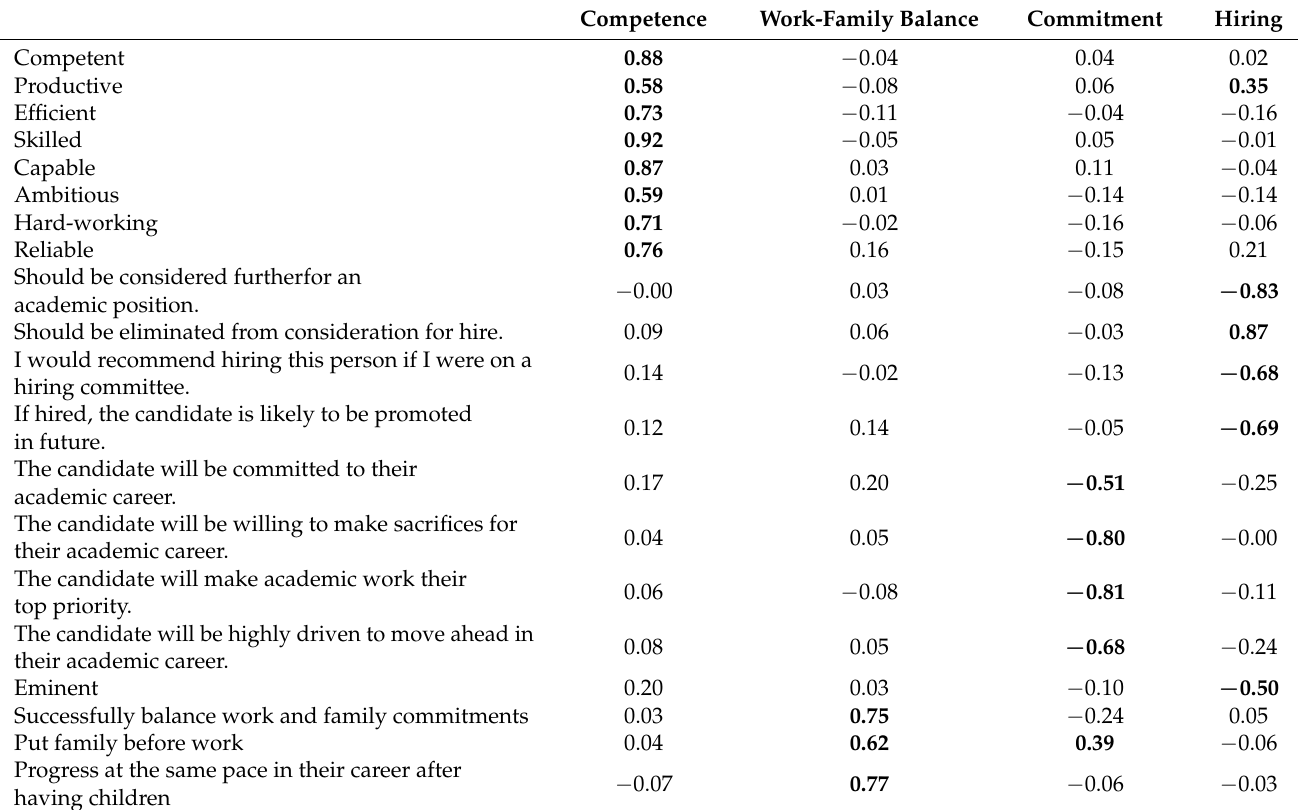
Table 1. Factor loadings and communalities based on a factor analysis with oblique